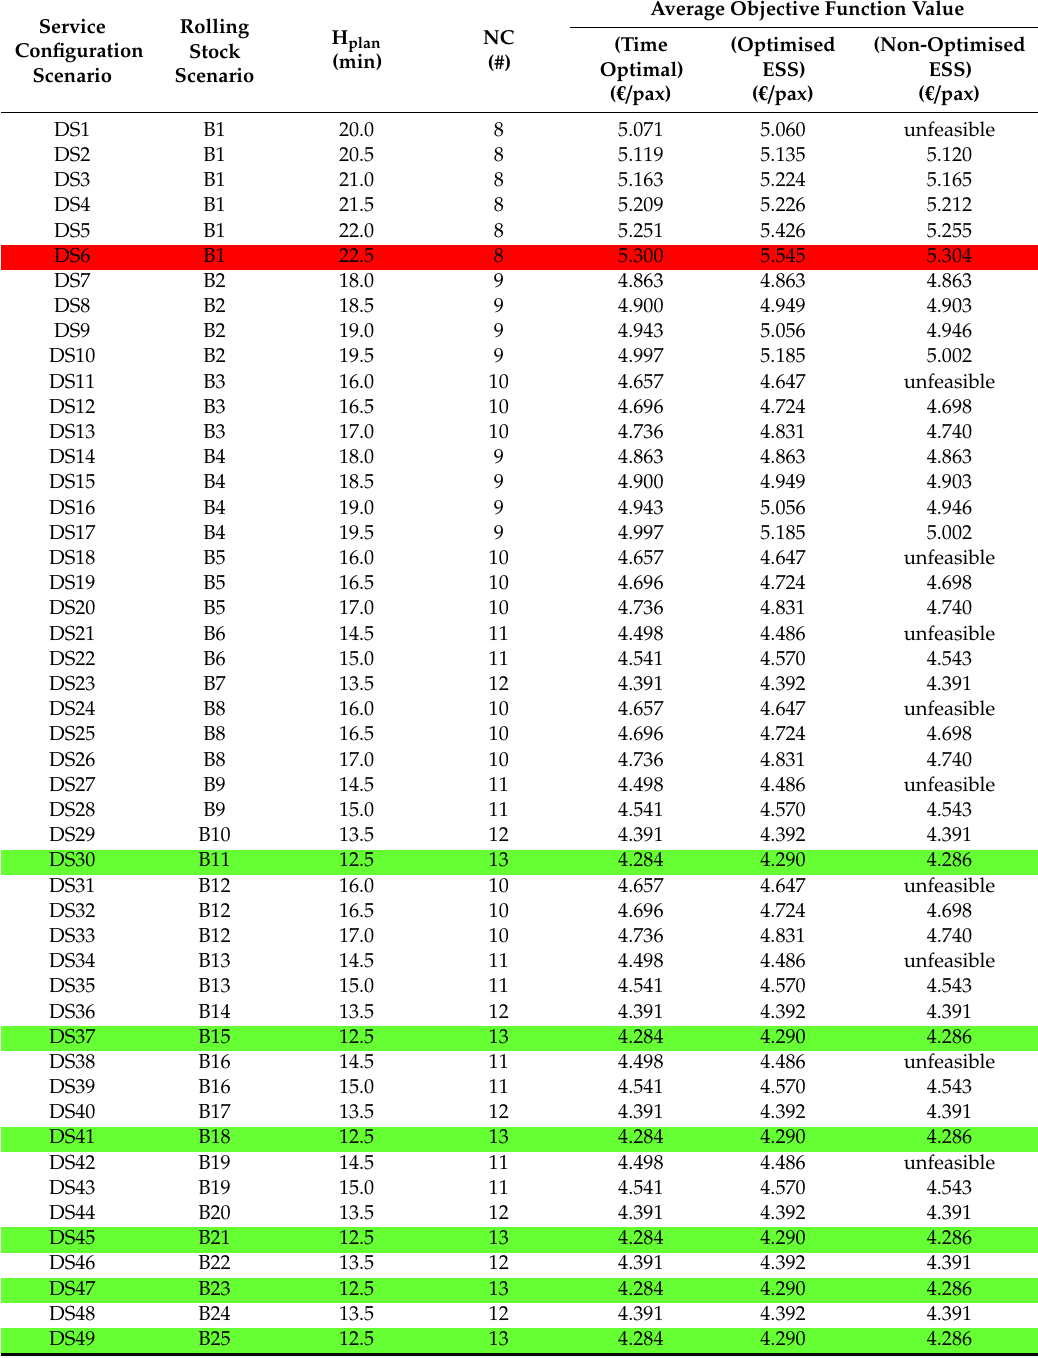
Table A3. Intervention scenario evaluation in disrupted